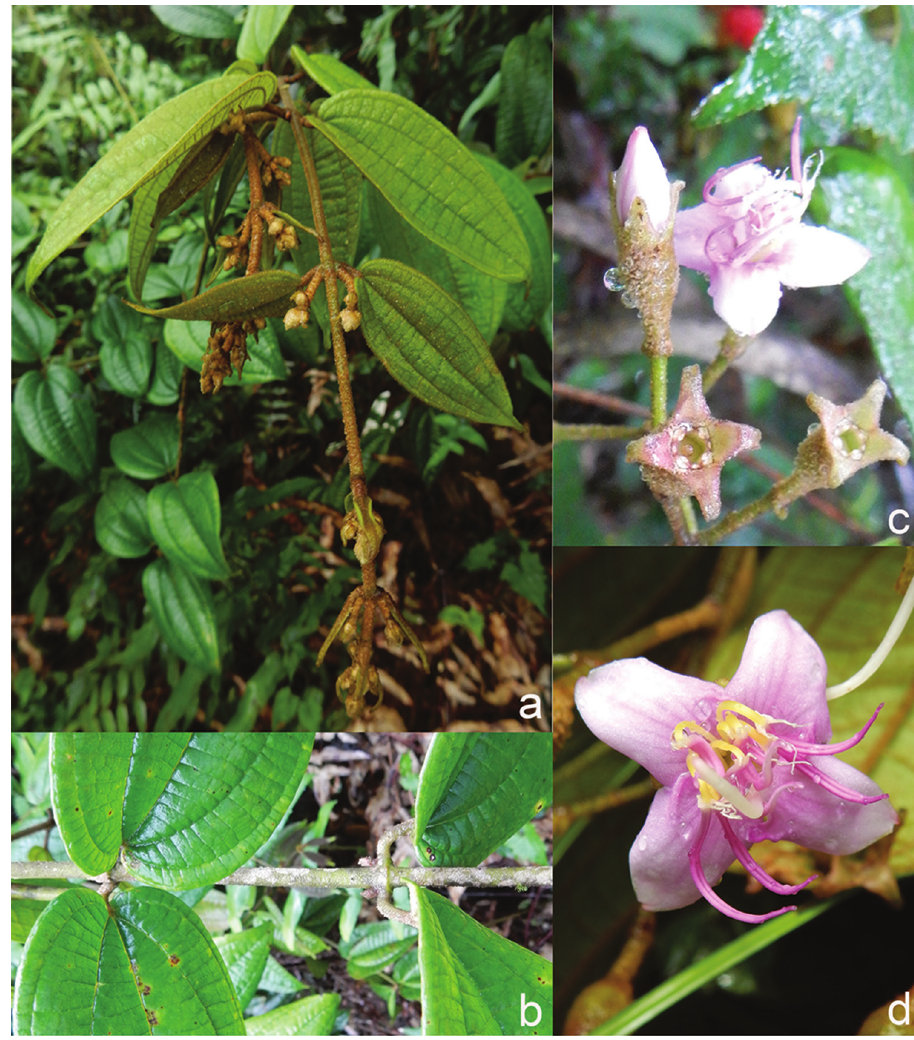
Figure 21. Dissochaeta macrosepala a habit b branchlet c hypanthium d flower Photographs by D. Pen- neys; voucher: Penneys 2512